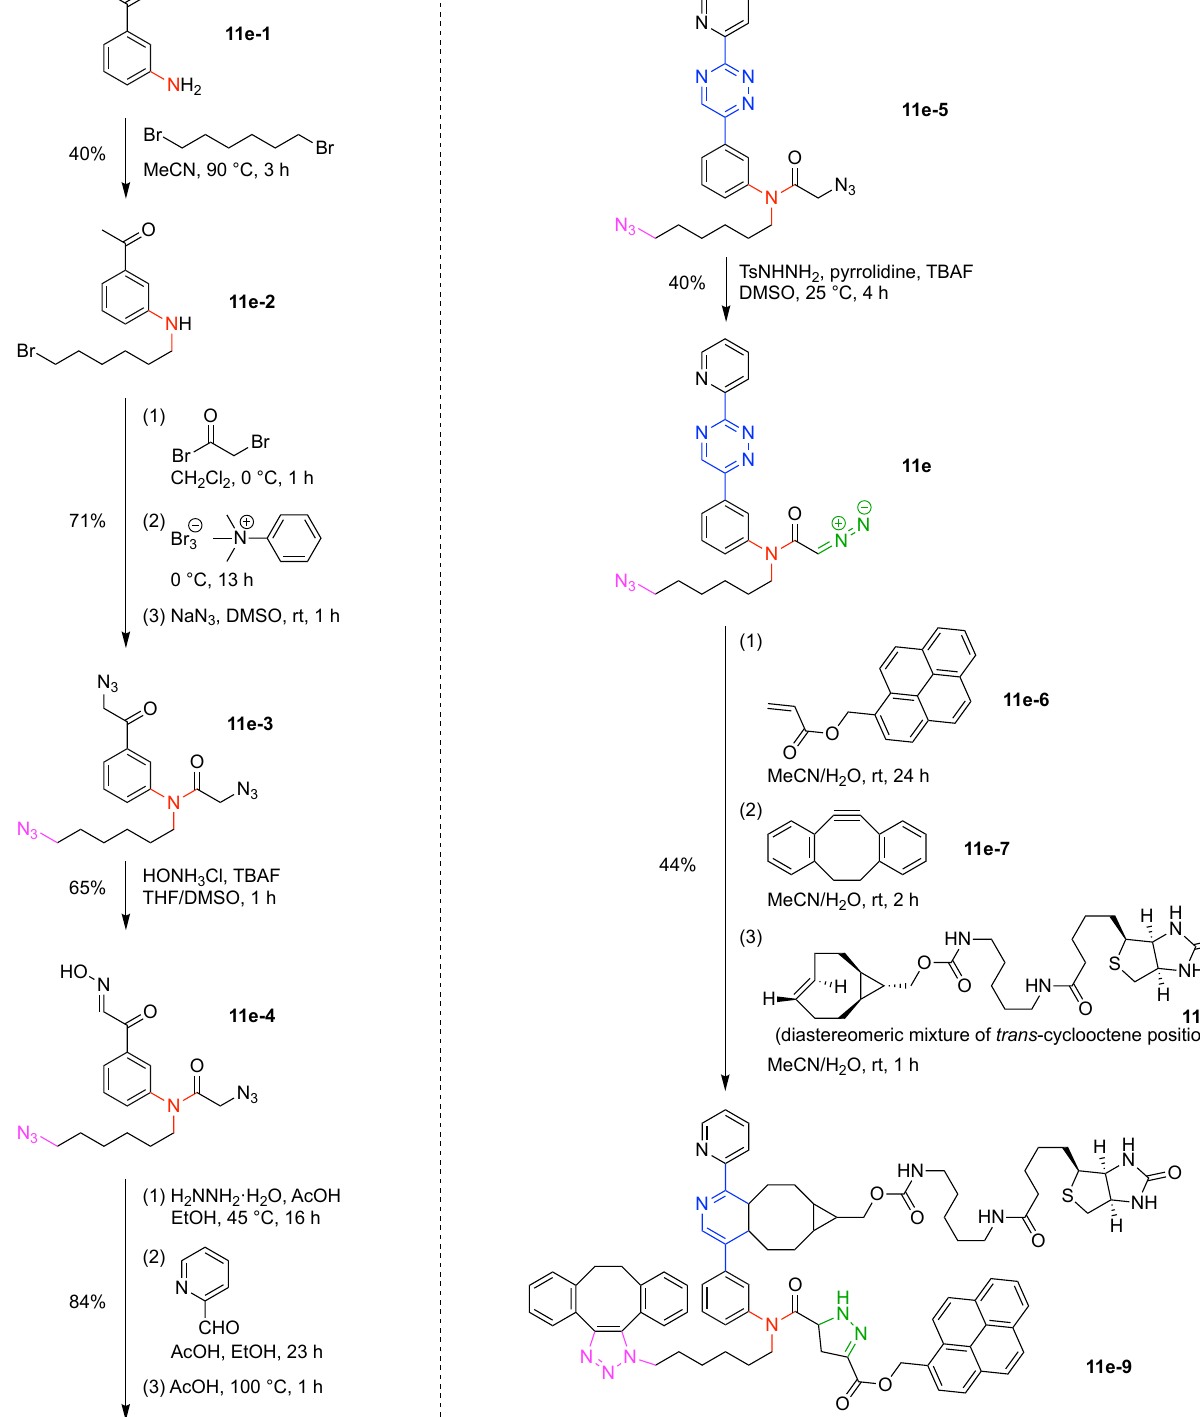
Figure 54. Synthesis of a triple-click conjugation scaffold built around a single nitrogen hub. A tetrafunctional photoaffinity probe bearing a m -nitroalkoxy substituted phenyltri- fluoromethyldiazirine unit ( 11f ) was developed (Figure 55) [272]. The probe is composed of a nitrogen hub and four functional units: (A) a biotin tag for affinity purification; (B) a m -nitrophenyl ether for cleavage by irradiation to simplify mass spectrometric analysis of